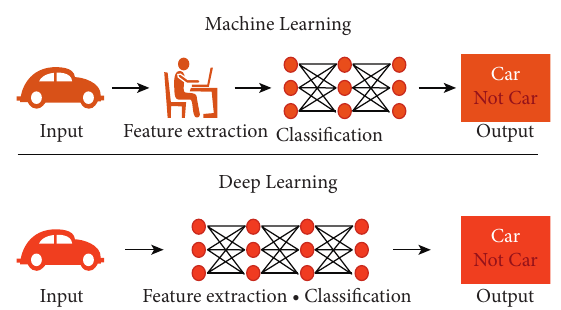
Figure 2: The difference between machine learning and deep learning